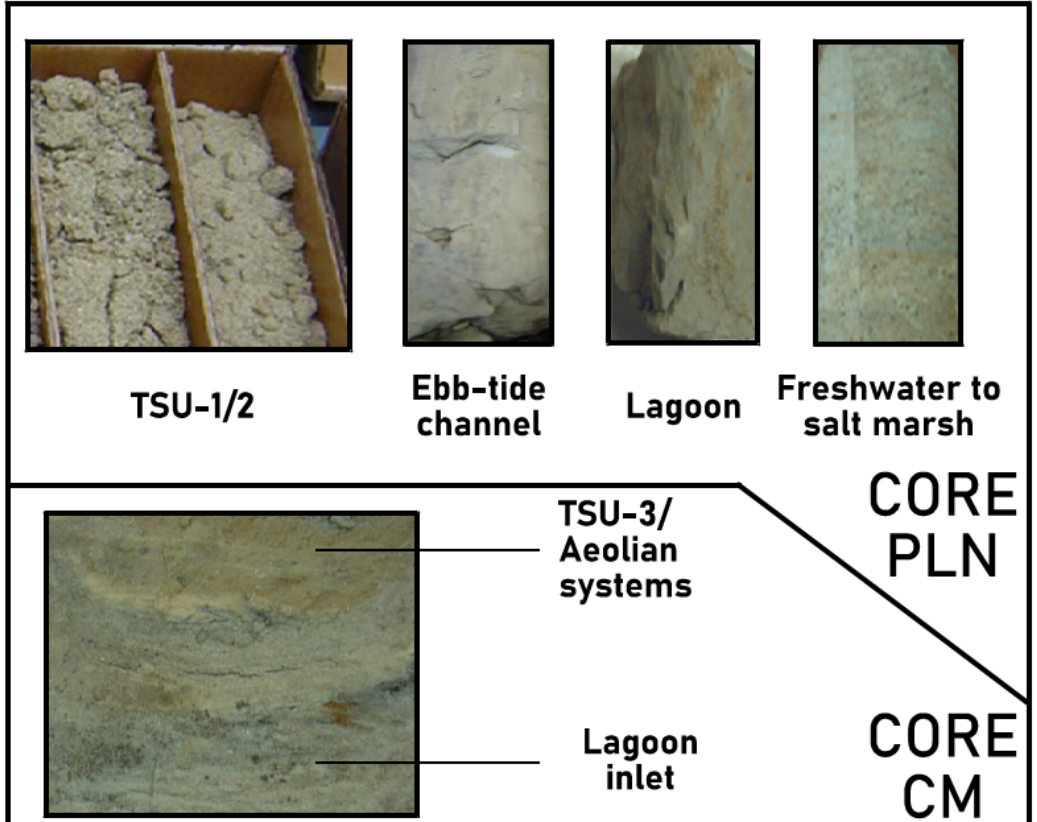
Figure 3. Cores PLN and CM: photos of the main facies.